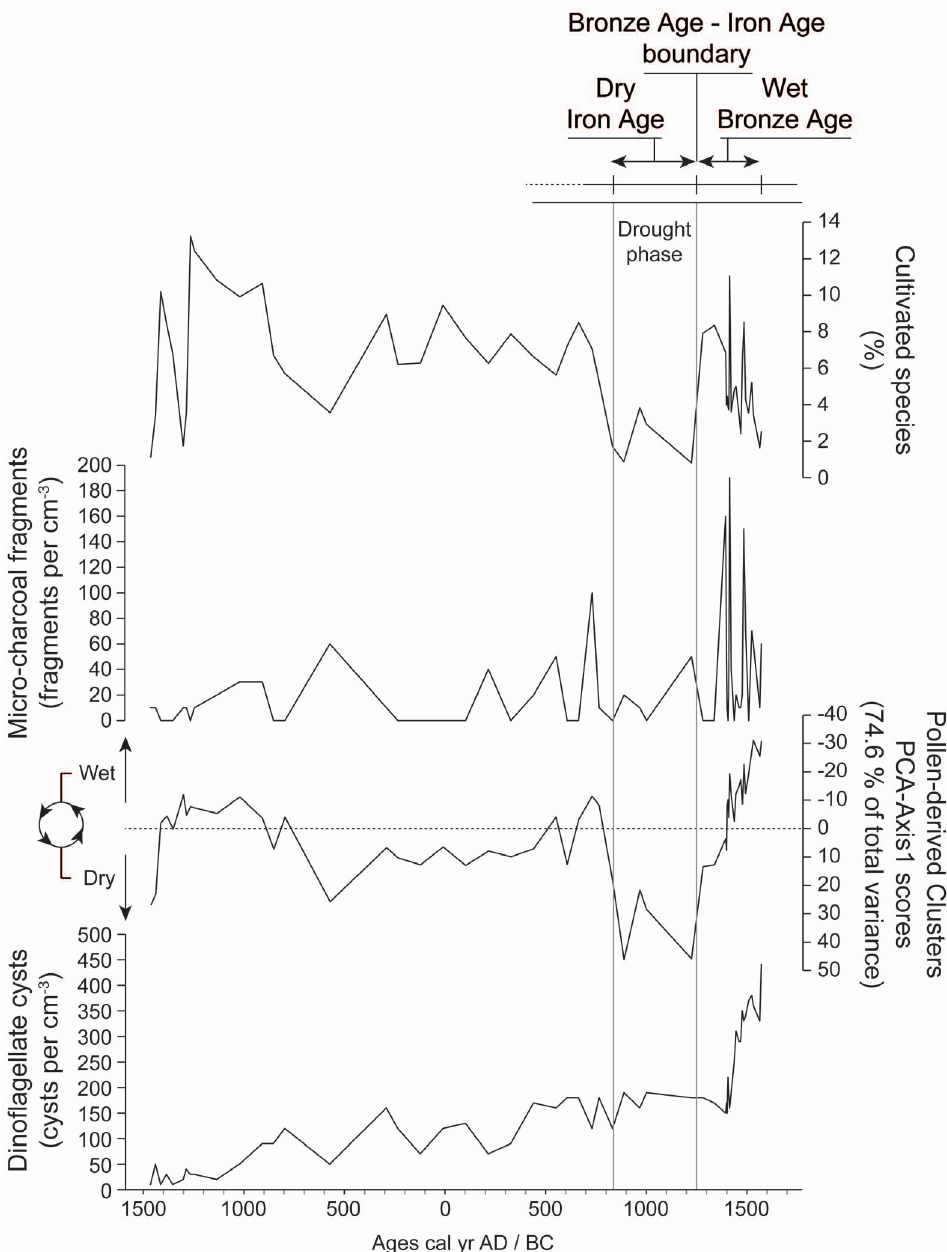
Figure 3. Pollen-derived climatology for the period 3500 years BP to present. The pollen-derived proxy of moisture availability is drawn as PCA-Axis 1 scores (PdVs). The cultivated species, charcoal fragments and dinoflagellate cysts are shown on a linear age-scale. The main climatic event, and the historical-cultural periods are indicated at the top of the diagram.